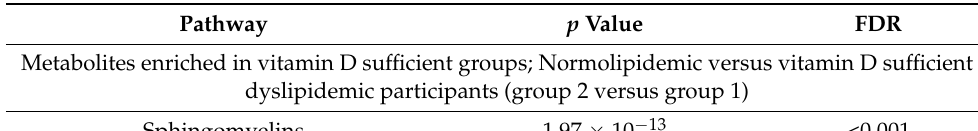
Metabolites enriched in different levels in vitamin D deficient Normolipidemic versus vitamin D